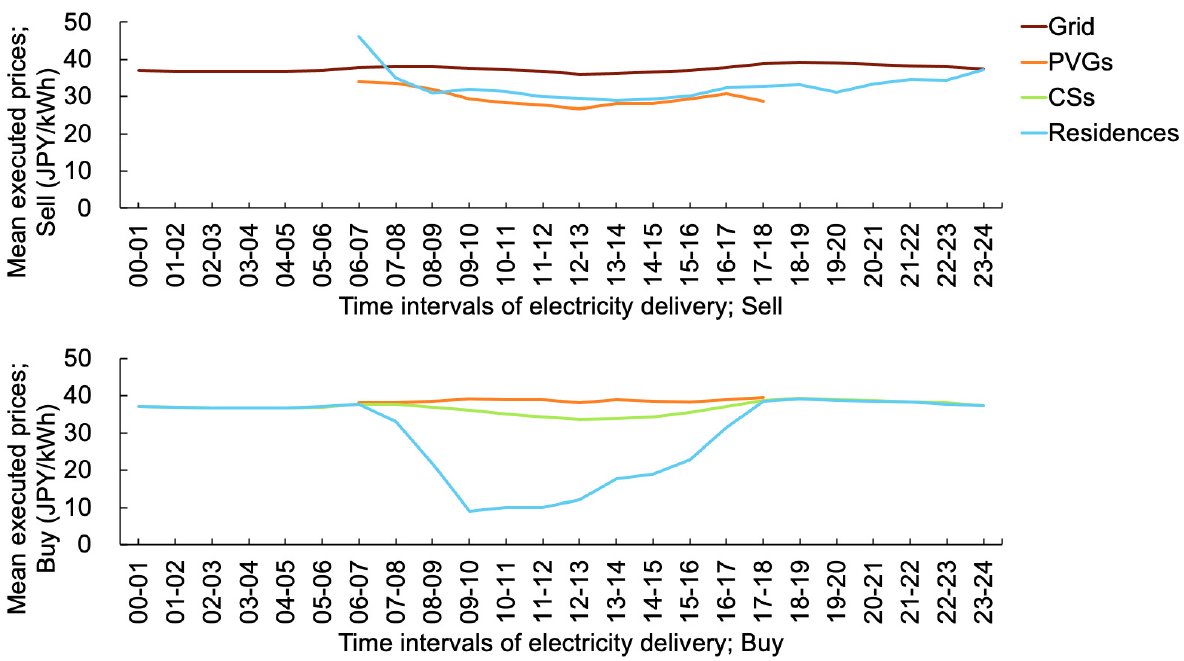
Figure 6. Total executed volumes for each time interval of electricity delivery in the target period.